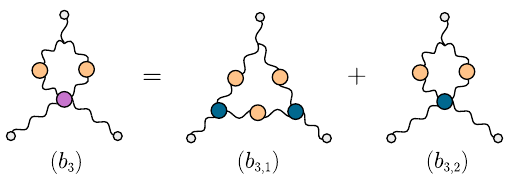
Fig. 3 The two contributions which arise from diagram ( b after performing the skeleton expansion of the four-gluon scattering kernel (purple blob)